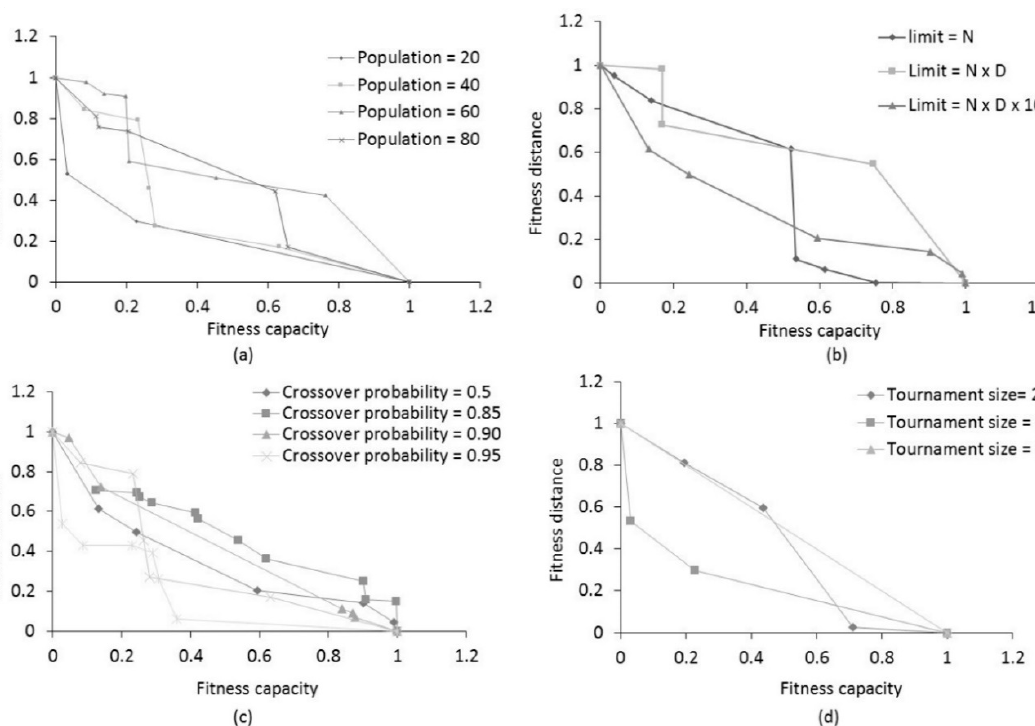
Figure 7. Parameter analysis. The optimal Pareto fronts when ( a ) the population size ranges from 20 to 80; ( b ) the parameter limit is set to population size, which is population size times the dimension size and times 100; ( c) the crossover probability ranges from 0.5 to 1; and ( d ) the tournament size ranges from 2 to 4.